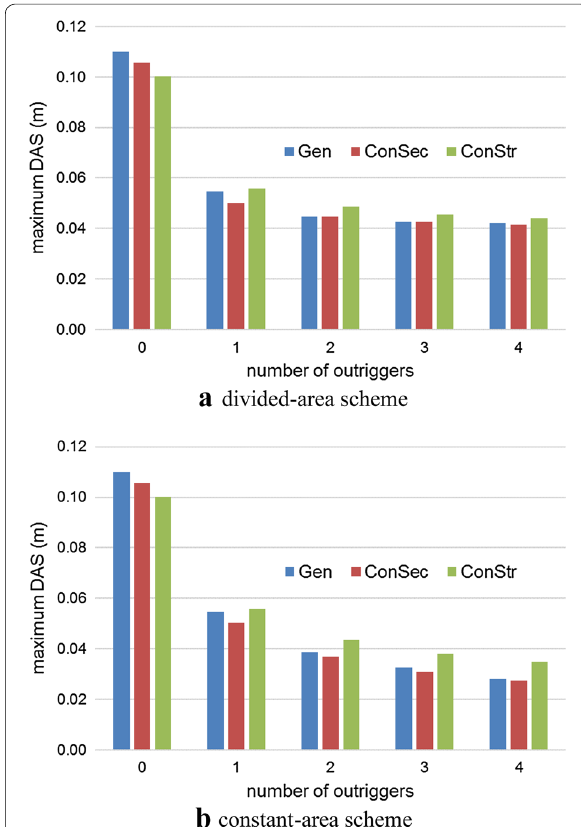
Fig. 8 Maximum differential axial shortenings according to number of outriggers.